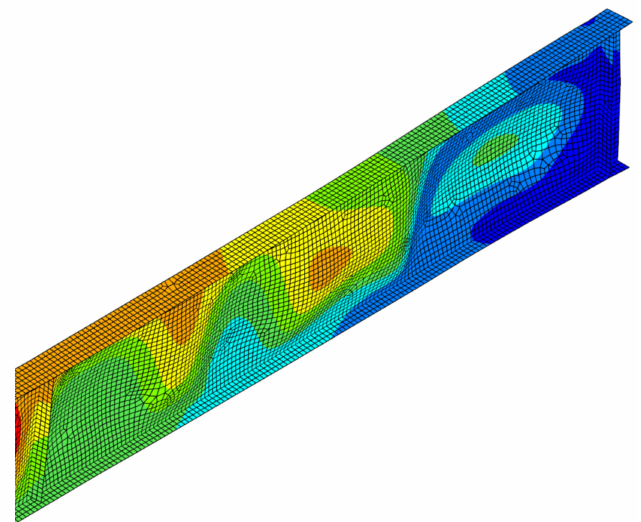
Figure 21. Local web buckling—beam B1 (web temperature 533 ◦ C, flange temperature 418 ◦ C), scale ×